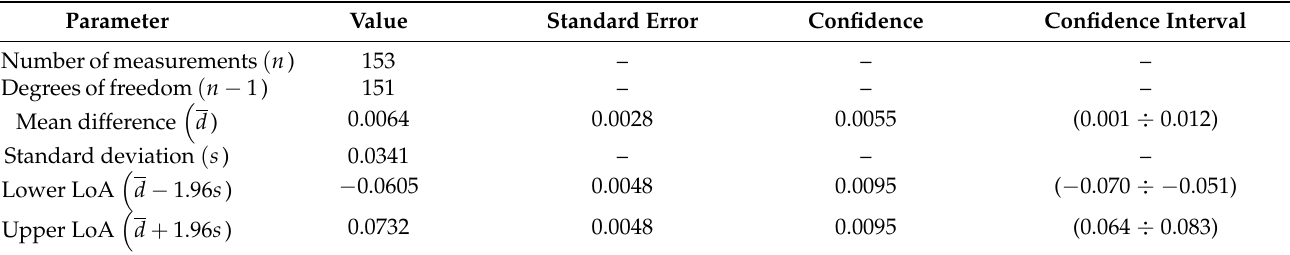
Figure 22. Bland and Altman plot—agreement between methods (deformation of left side of arch support frame). Table 3. Bland and Altman plot statistics (left side of arch support frame).